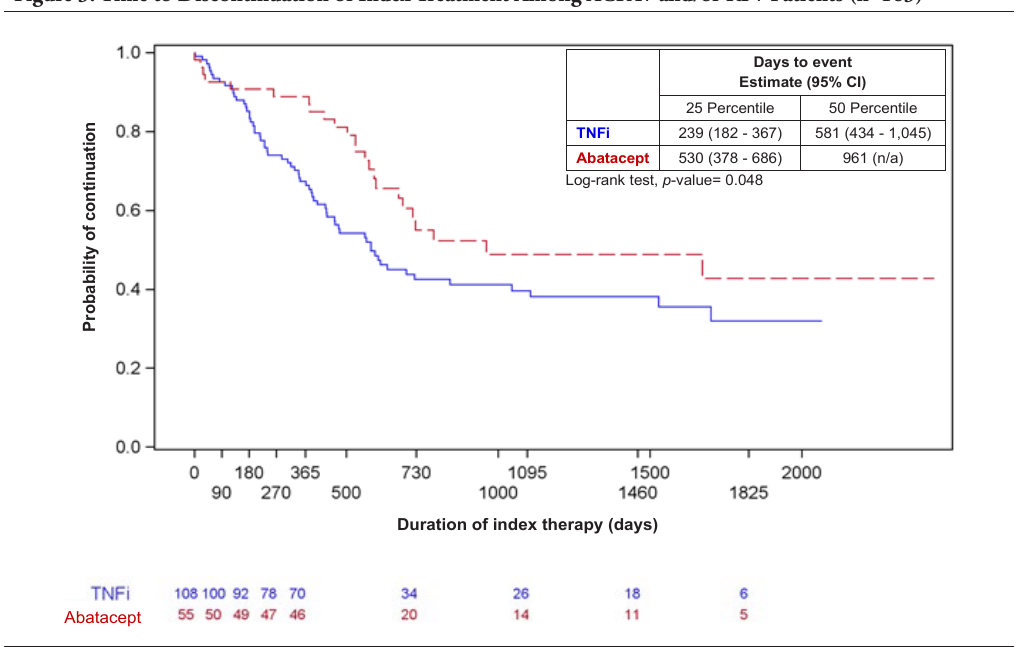
Figure 3. Time to Discontinuation of Index Treatment Among ACPA+ and/or RF+ Patients